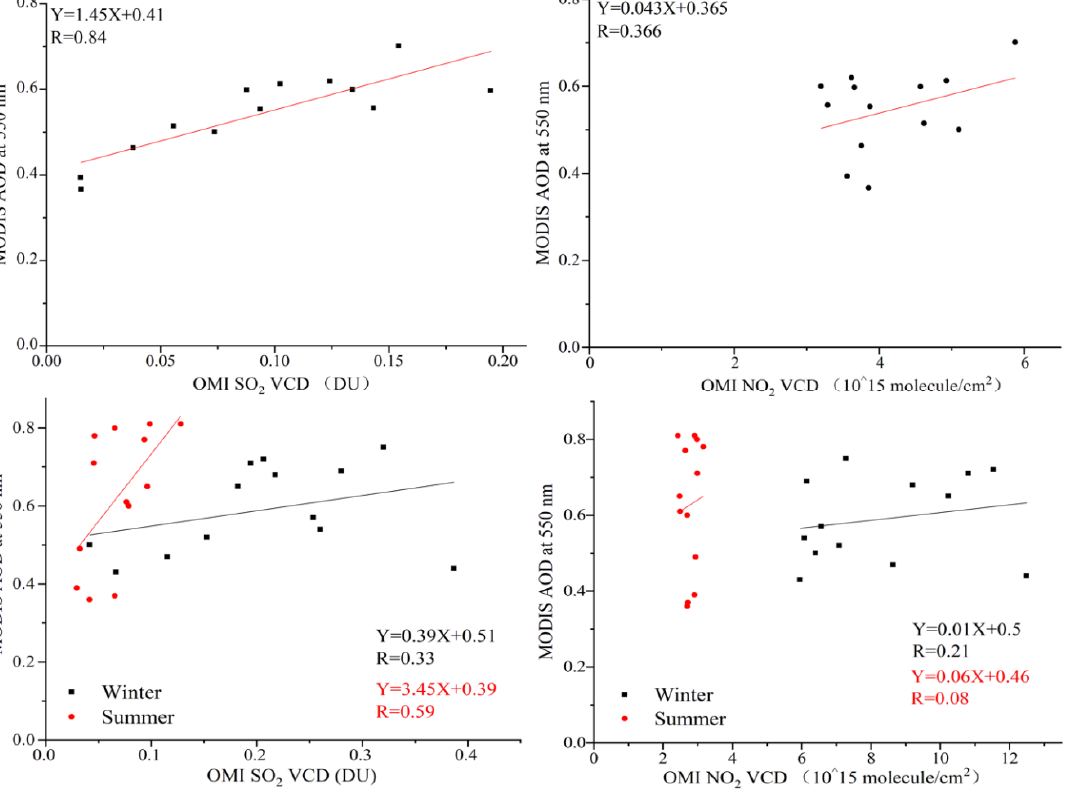
Figure 12. Correlation of annual (top) MODIS AOD at 550 nm, with SO 2 and VCD (left), and NO 2 and VCD (right) over Hubei, in winter and summer (bottom), respectively.